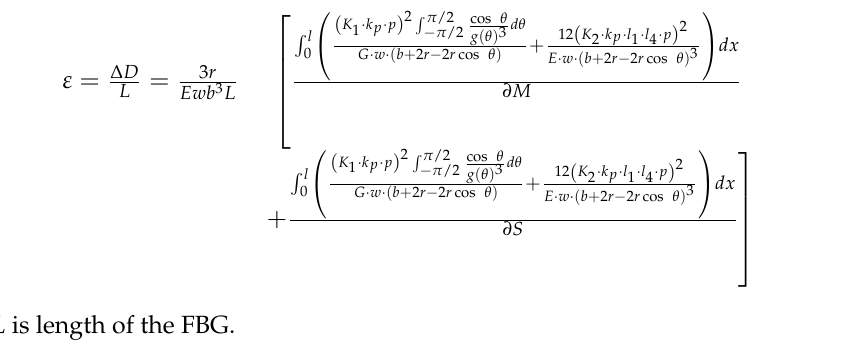
Figure 7. Mechanical diagram for one-half model.